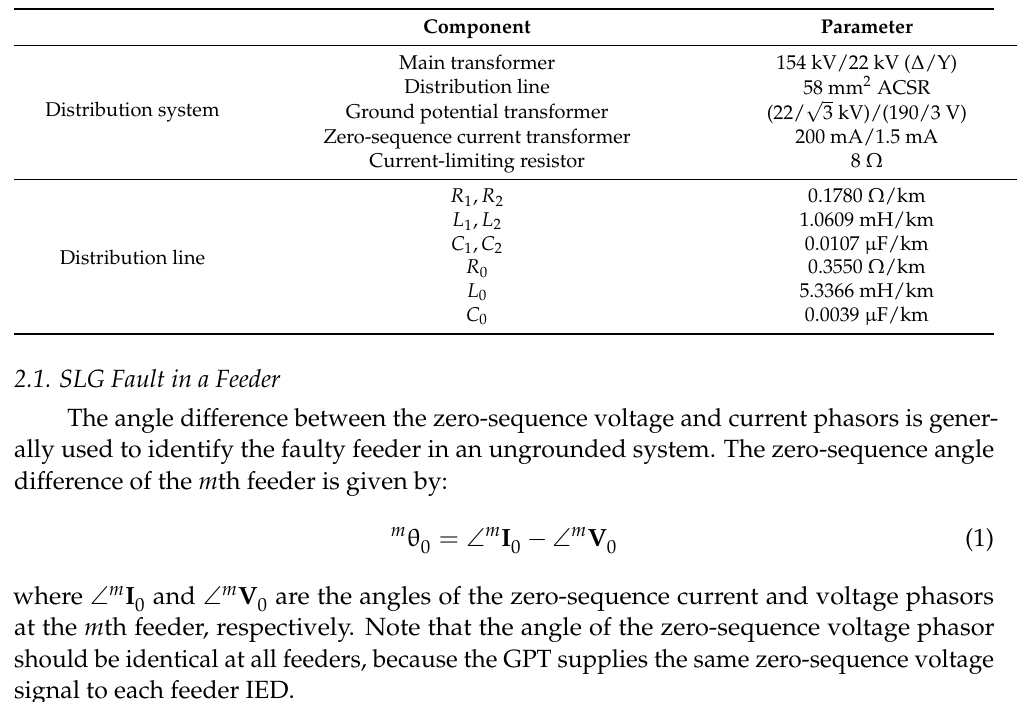
Figure 1. The ungrounded distribution system under study. Table 1. System configuration.